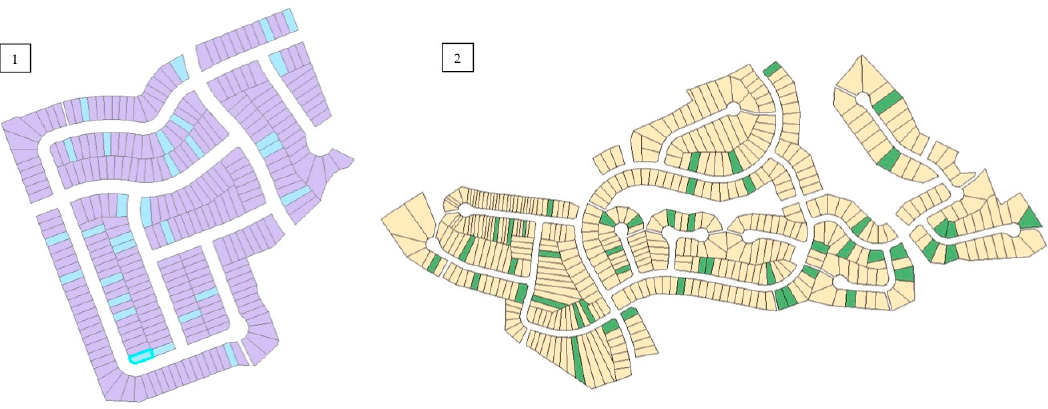
Figure 2. Aerial imagery showing the development of Millview (Halifax, Nova Scotia) from woodland to subdivision. Source: Google Earth © DigitalGlobe.